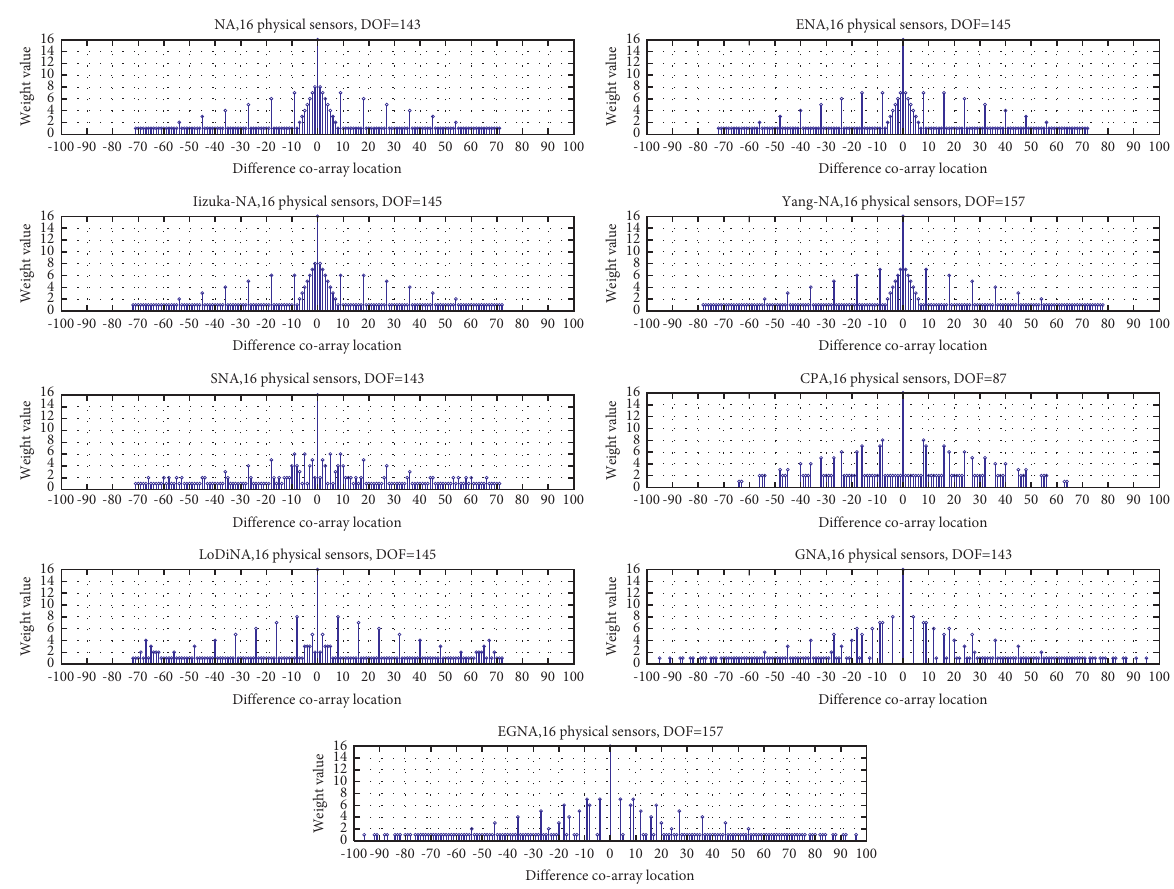
Figure 8: Comparison of difference coarray location for different array